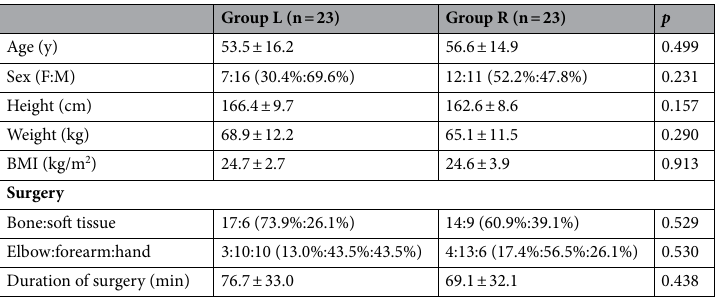
Complete sensory block Complete motor Time (min)